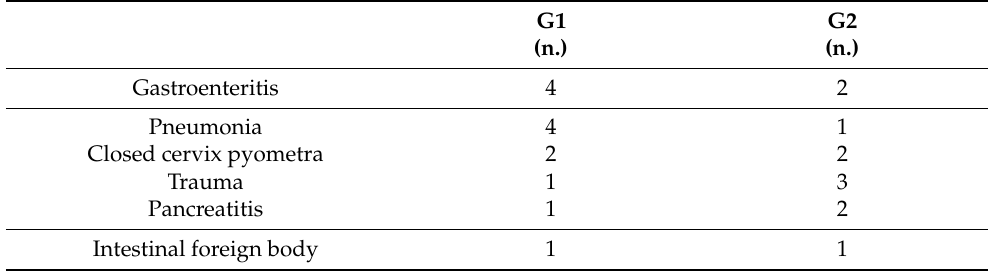
Table 3. Origin of SIRS in dogs belonged G1 and G2.